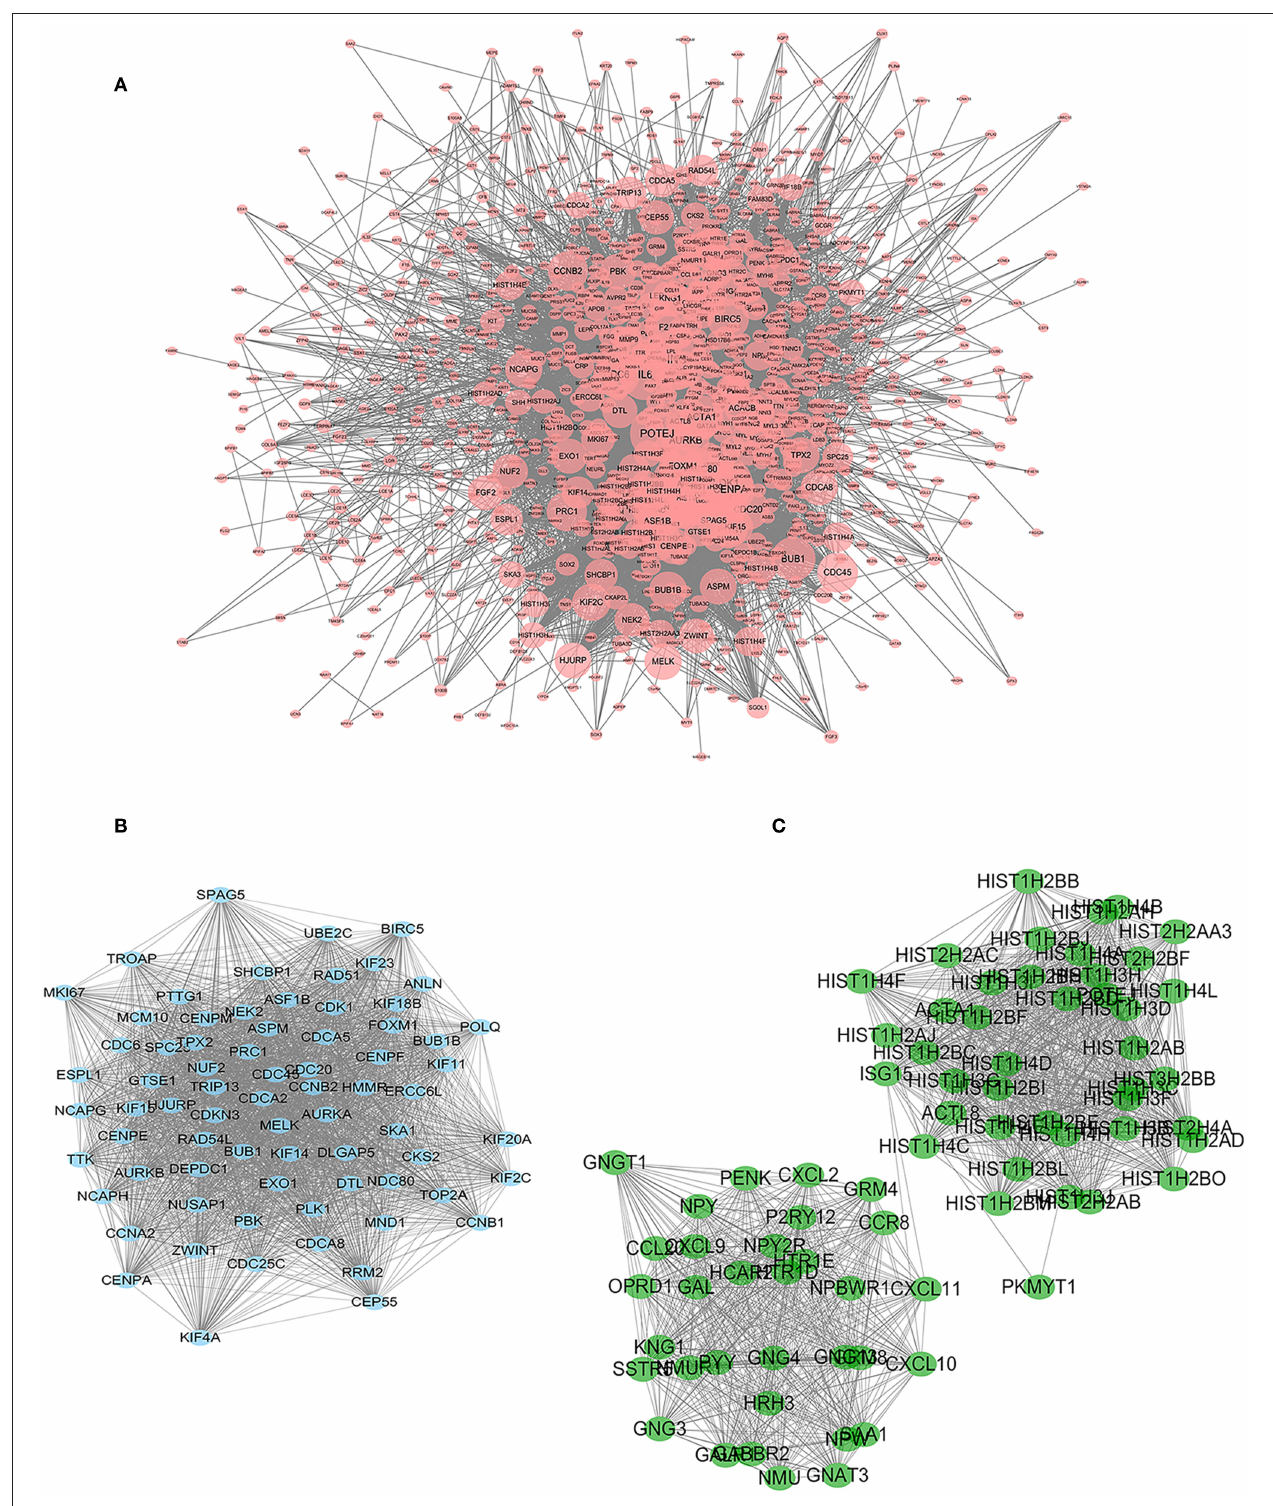
FIGURE 4 | PPI network of significant DEGs. Two subnetworks and 148 nodes were identified by Cytoscape MCODE plugin. (A) PPI network with 1,133 nodes and 11,112 edges. The size of the node increases with the size of the degree. (B) Module 1 contains 73 nodes and 2,497 edges ( P < 0.05). (C) Module 2 contains 75 nodes and 1,317 edges ( P <